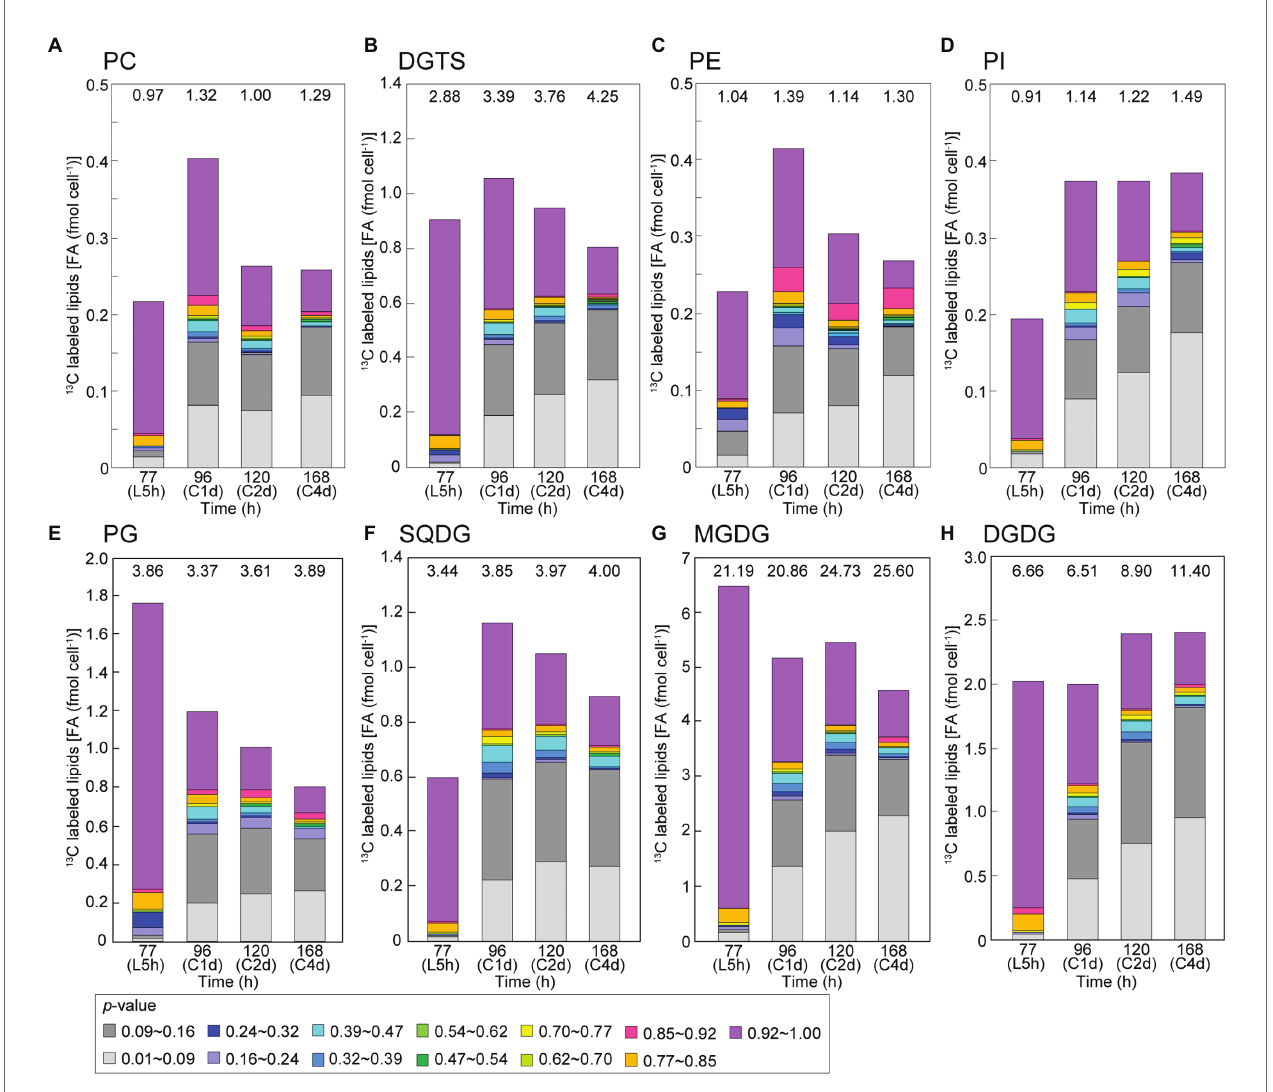
FIGURE 8 | Composition of isotopic abundance populations in the fatty acids in individual classes of polar lipids in the [ 13 C]bicarbonate labeling and chase experiments. (A) Phosphatidylcholine (PC); (B) diacylglyceryl- N,N,N -trimethylhomoserine (DGTS); (C) phosphatidylethanolamine (PE); (D) phosphatidylinositol (PI); (E) phosphatidylglycerol (PG); (F) sulfoquinovosyl diacylglycerol (SQDG); (G) monogalactosyl diacylglycerol (MGDG); and (H) digalactosyl diacylglycerol (DGDG). Total amount of lipids (as fatty acids) is shown on